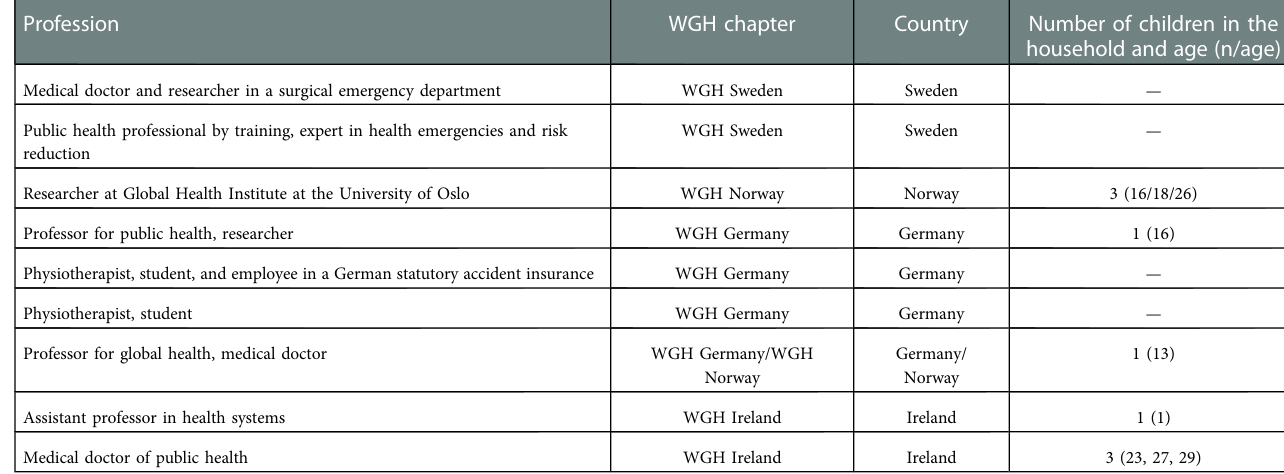
TABLE 2 Sample characteristics of participants.